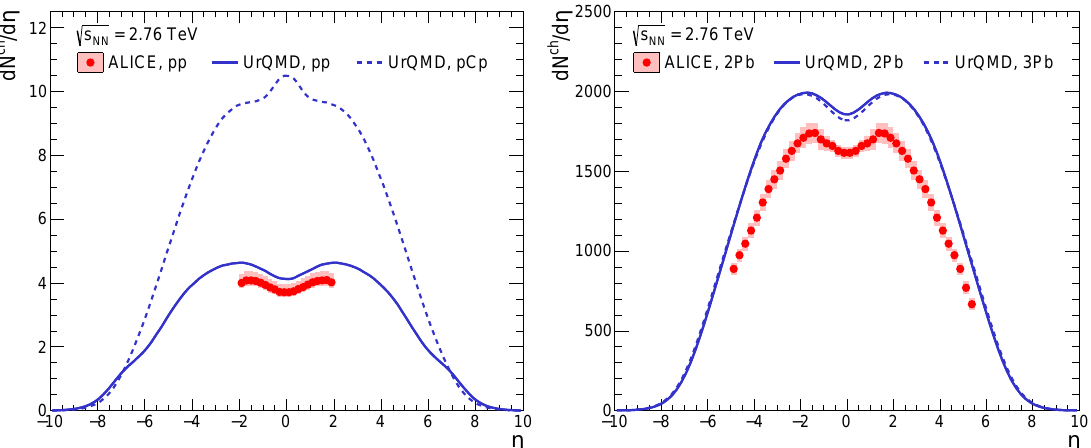
found in the d η √ s NN = 2.76 TeV (symbols) vs. the UrQMD